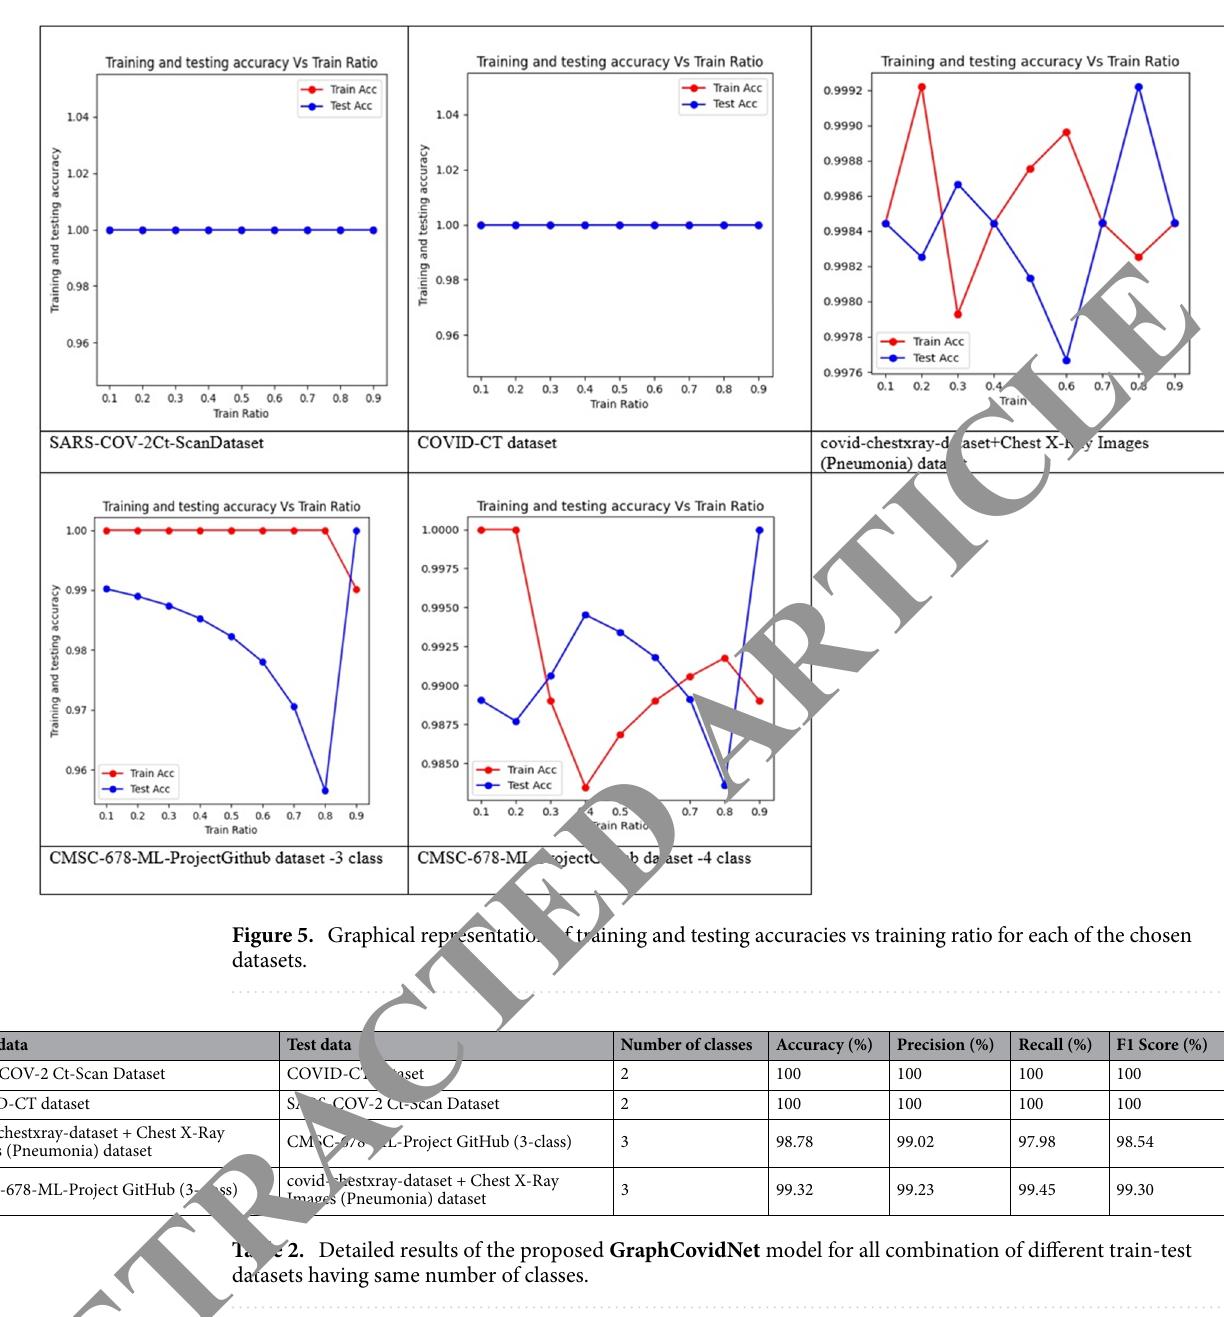
Table 2. Detailed results of the proposed GraphCovidNet model for all combination of different train-test datasets having same number of classes.